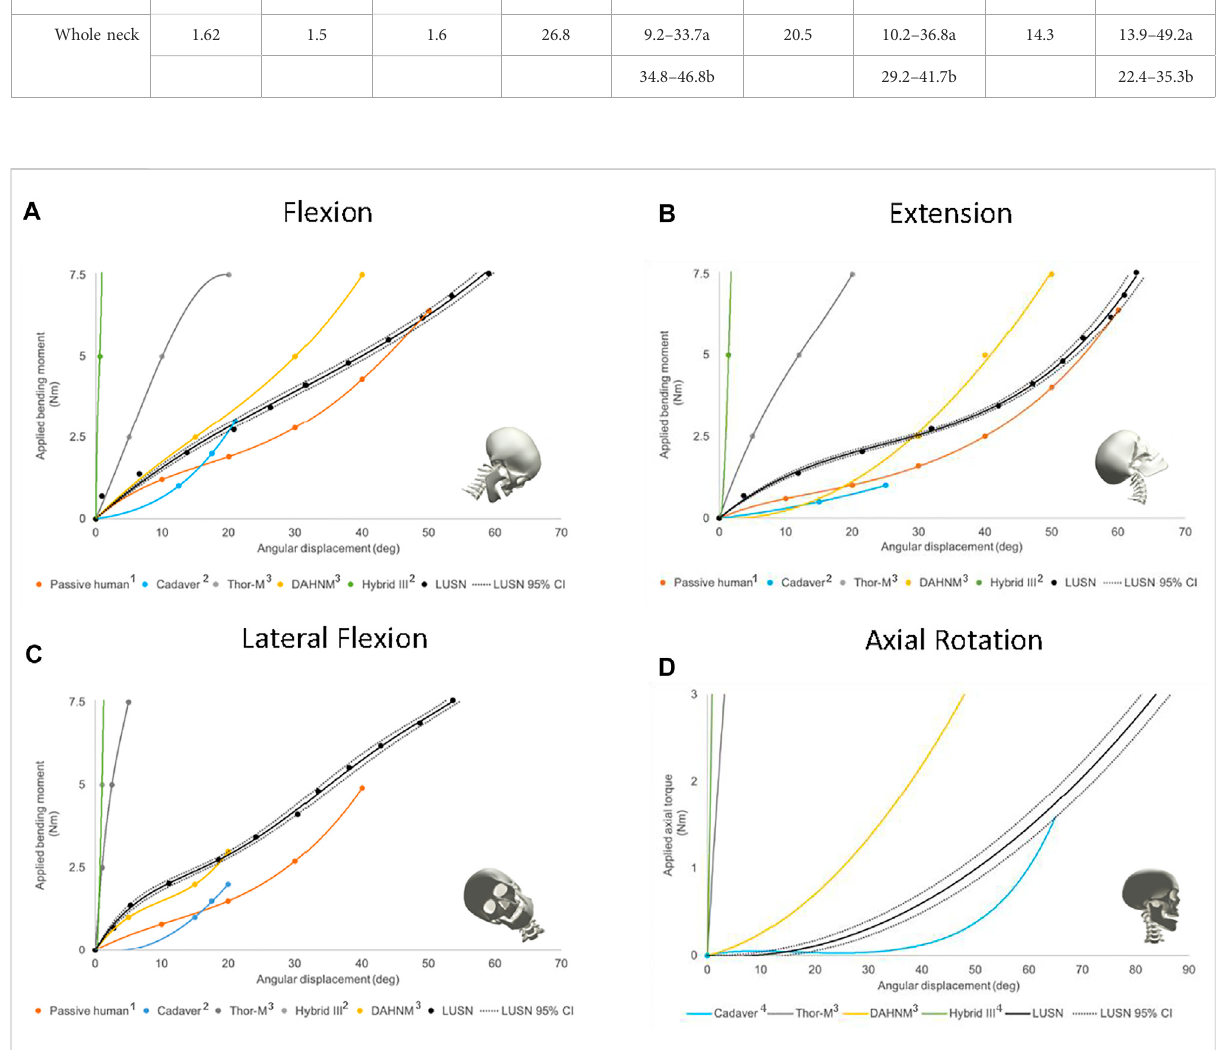
Thevalidatedmomentortorque versus angleresponsecorridorsoftheLUSNwithrespecttothebestavailablehumanandsurrogatedatain: (A) Flexion bending (B) Extension bending (C) Lateral fl exion bending (D) Axial rotation.